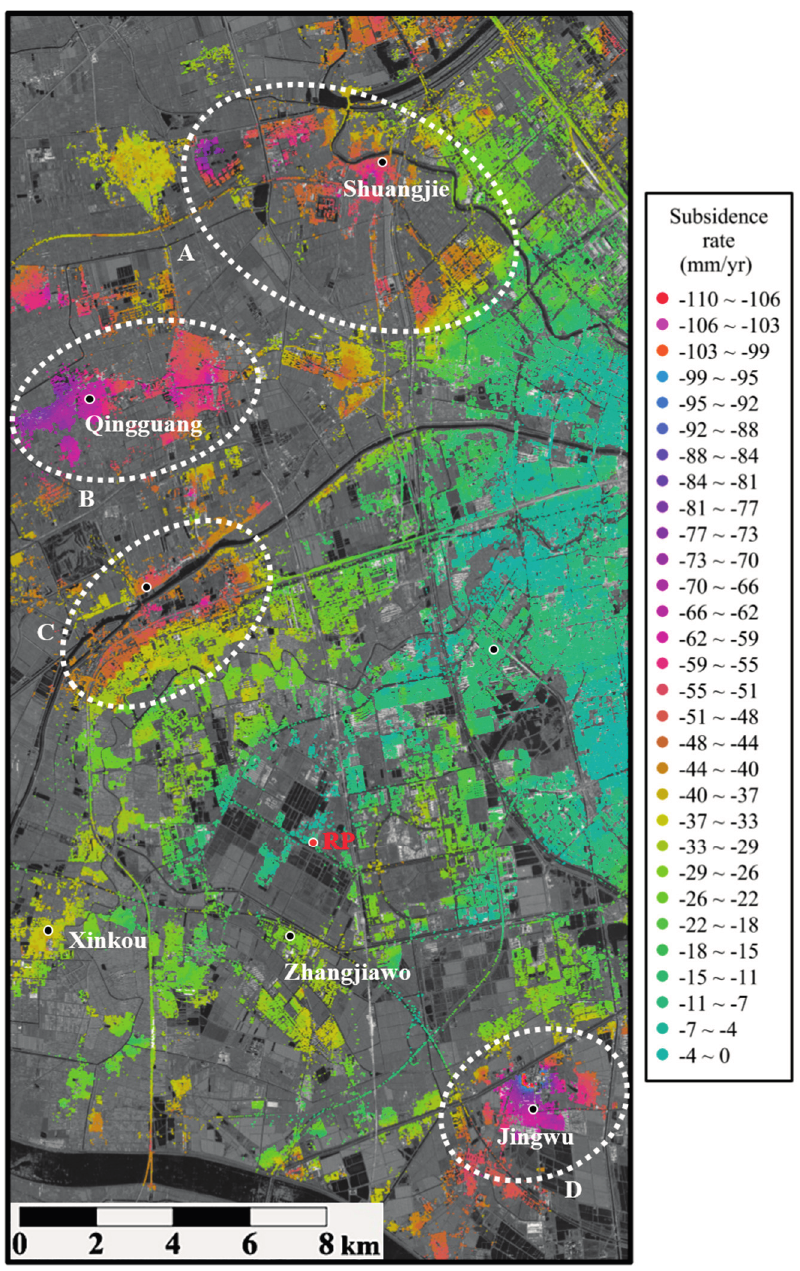
Figure 7. The subsidence rates at all the PSs derived by the proposed hierarchical